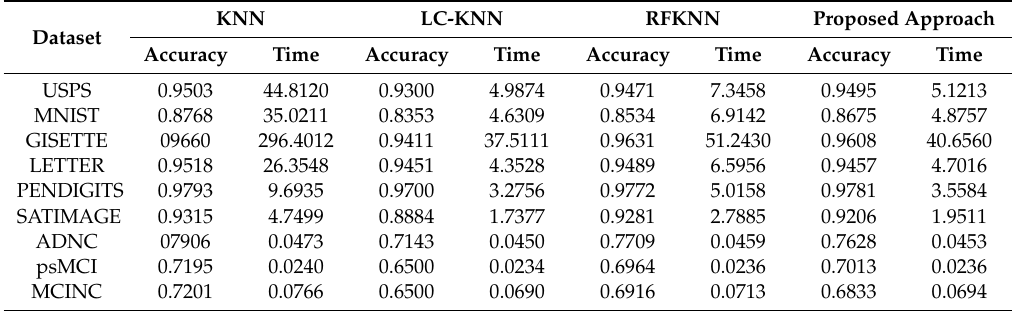
Table 3. Classification accuracy and time cost of the proposed approach in comparison to the other related works on di ff erent